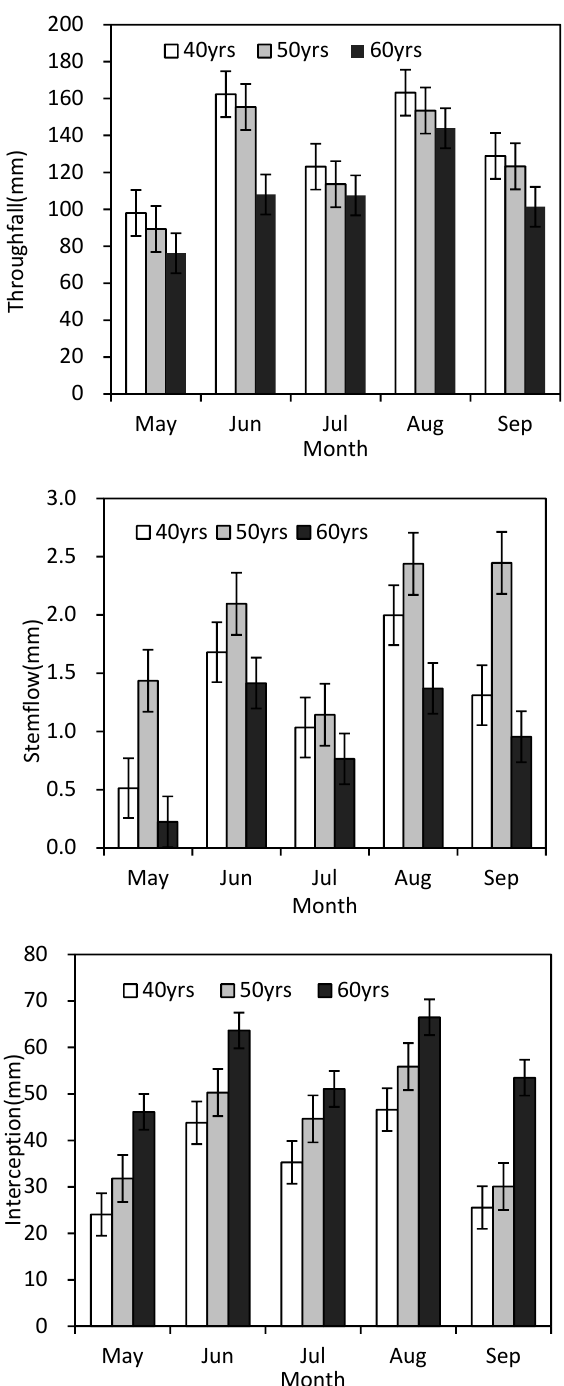
Figure 3. The amount of throughfall, stemflow and interception in five different months during the study period.